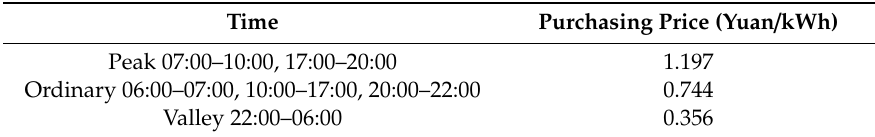
Table 1. Peak / ordinary / valley electricity price.